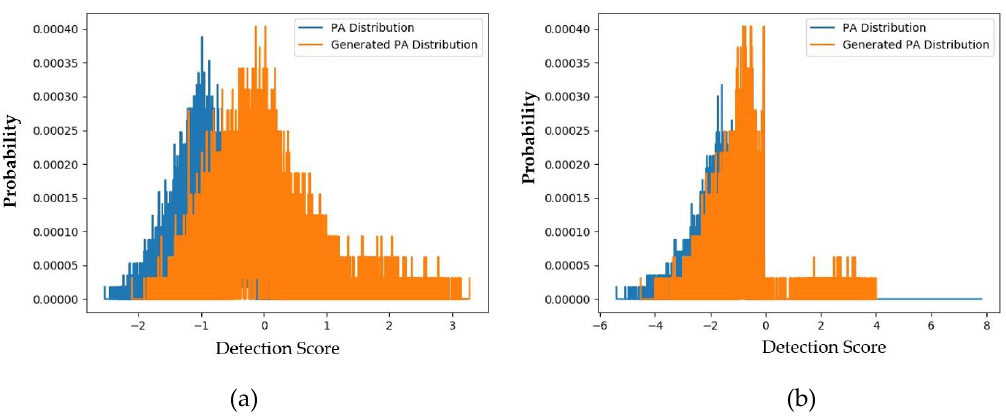
Figure 10. Distribution of detection scores of captured PA images versus the generated PA images with the Replay-mobile dataset ( a ) using the handcrafted-based face-PAD method [50]; ( b ) using the deep-learning-based face-PAD method [15].